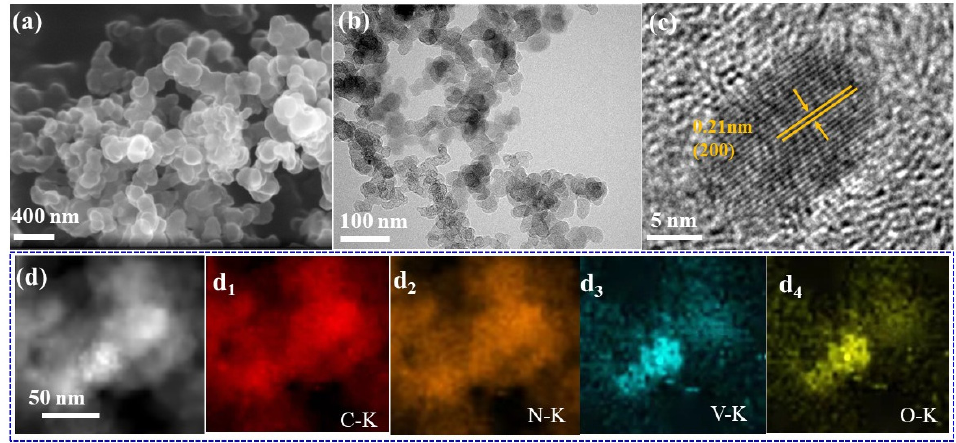
Figure 1. ( a ) FESEM, ( b ) TEM, and ( c ) HRTEM images of VN/NC/C-3. ( d , d 1 – d 4 ) EDS elemental mapping of C, N, V, and O.